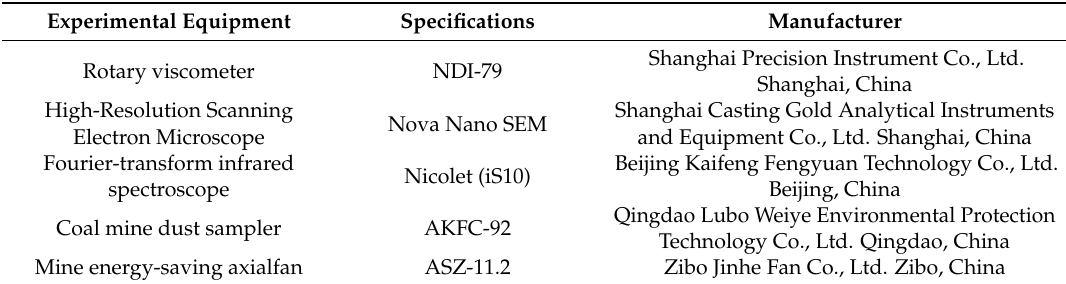
Table 2. Key experimental equipment and